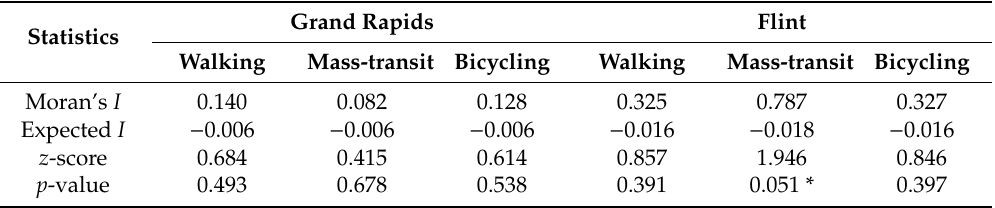
Table 4. Moran’s I test of revealed accessibility index (RAI) in each city’s active living zone. Grand Rapids Flint Statistics Walking Mass-transit Bicycling Walking Mass-transit Bicycling Moran’s I